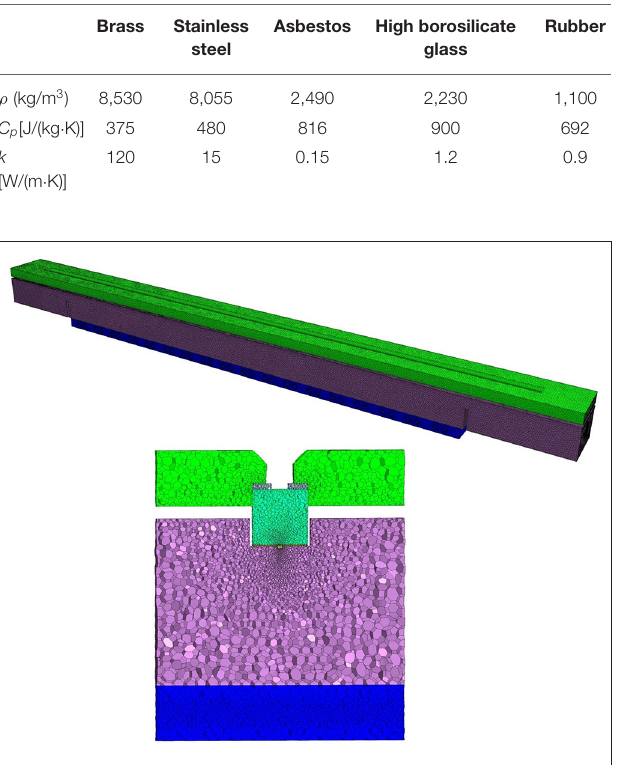
FIGURE 5 | The mesh of numerical model.